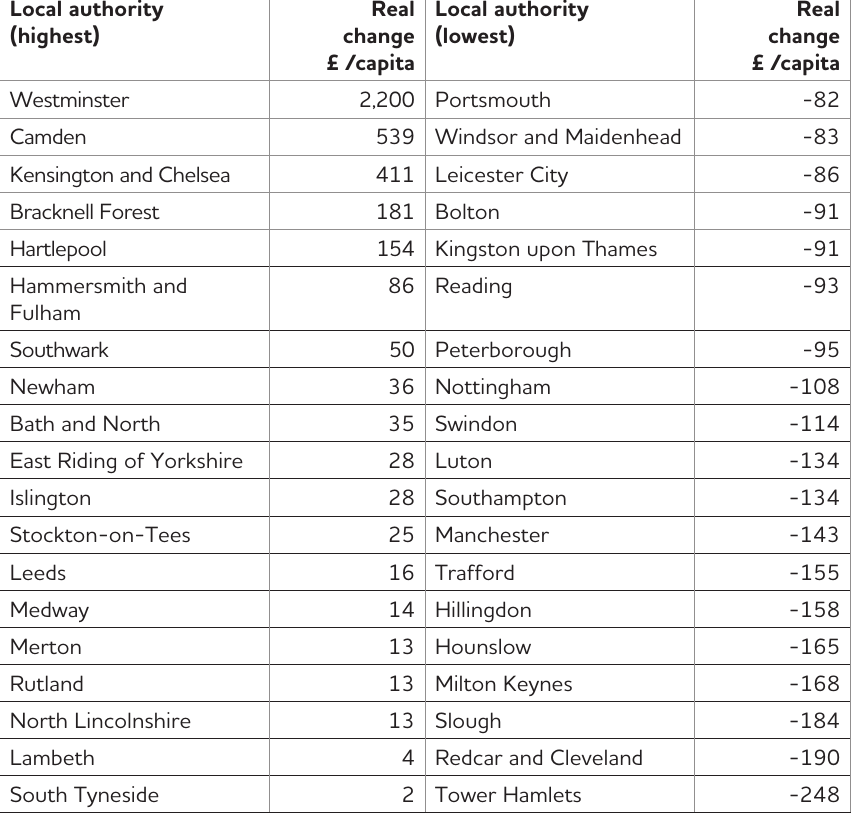
Table 3: Changes in non-domestic (business) rate income for all-purpose authorities in England with the highest and lowest changes,